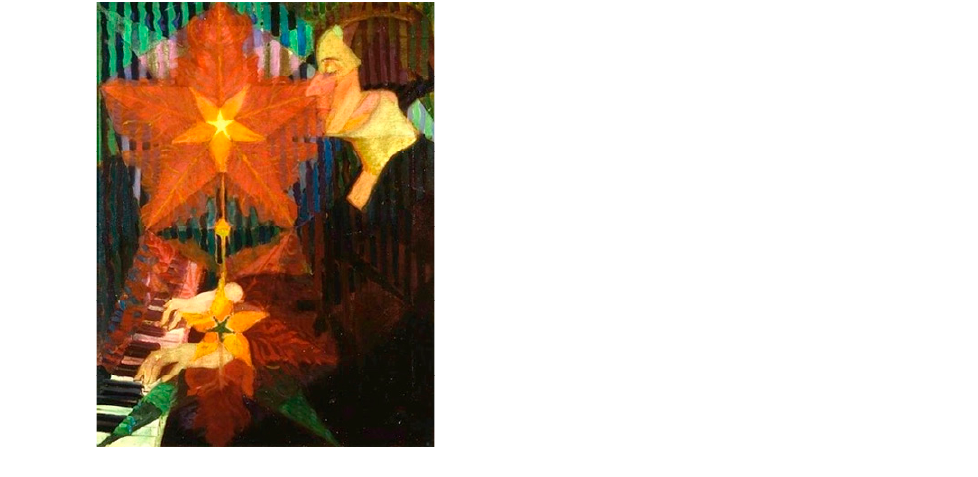
Figure 10. Frederick John de St. Vrain Schwankovsky, Modern Music , 1920, Oil on canvas, 66 × 51 cm, Laguna Art Museum, Laguna Beach, California.